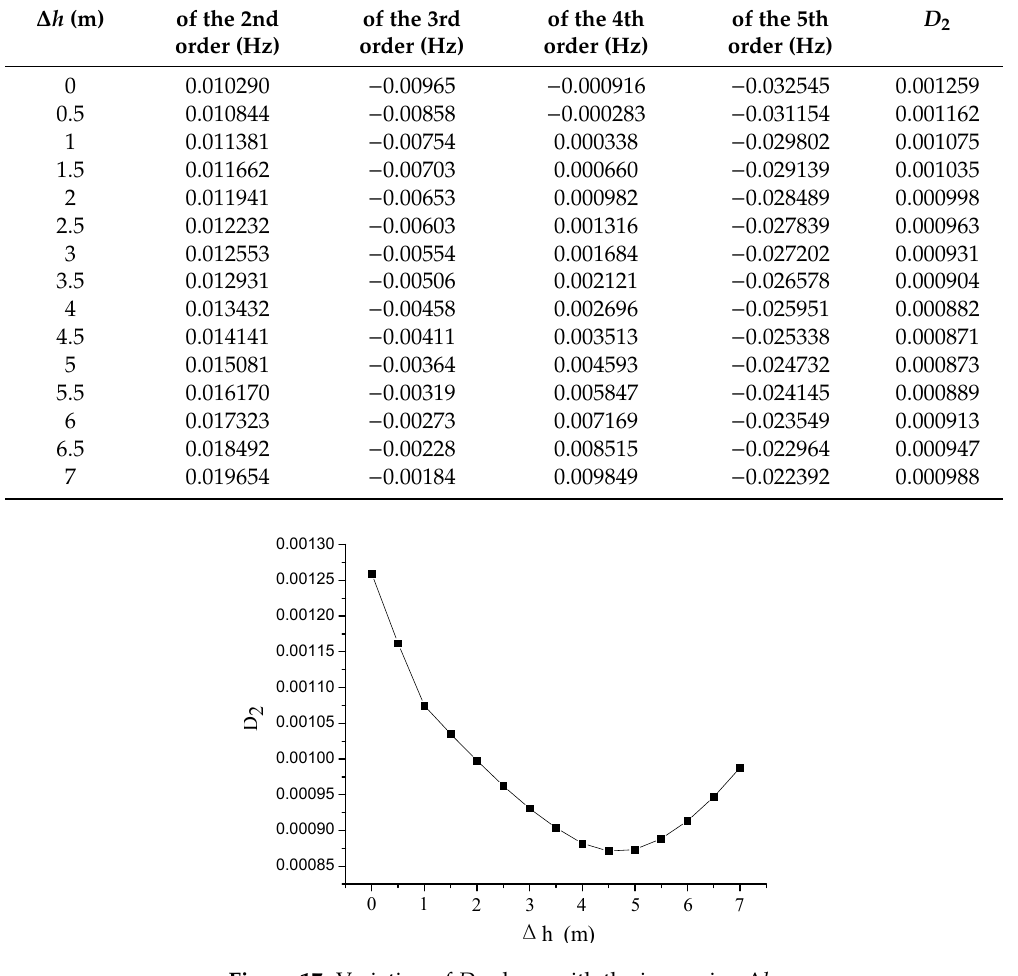
Figure 17. Variation of D 2 along with the increasing ∆ h . Table 9. Comparison between measured and simulated frequency